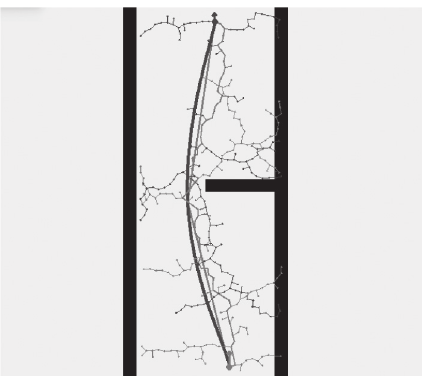
Figure 18: The Bi-RRT planning result in high-level model.